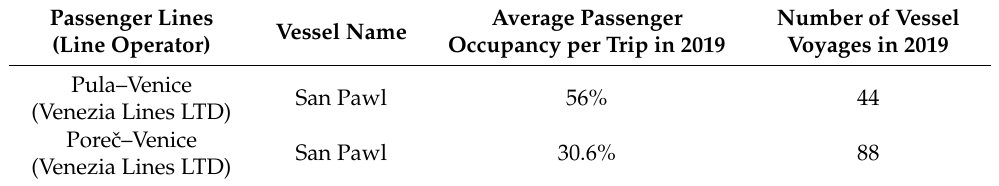
Table 3. Existing passenger lines serviced in 2019 between selected route segments. Passenger